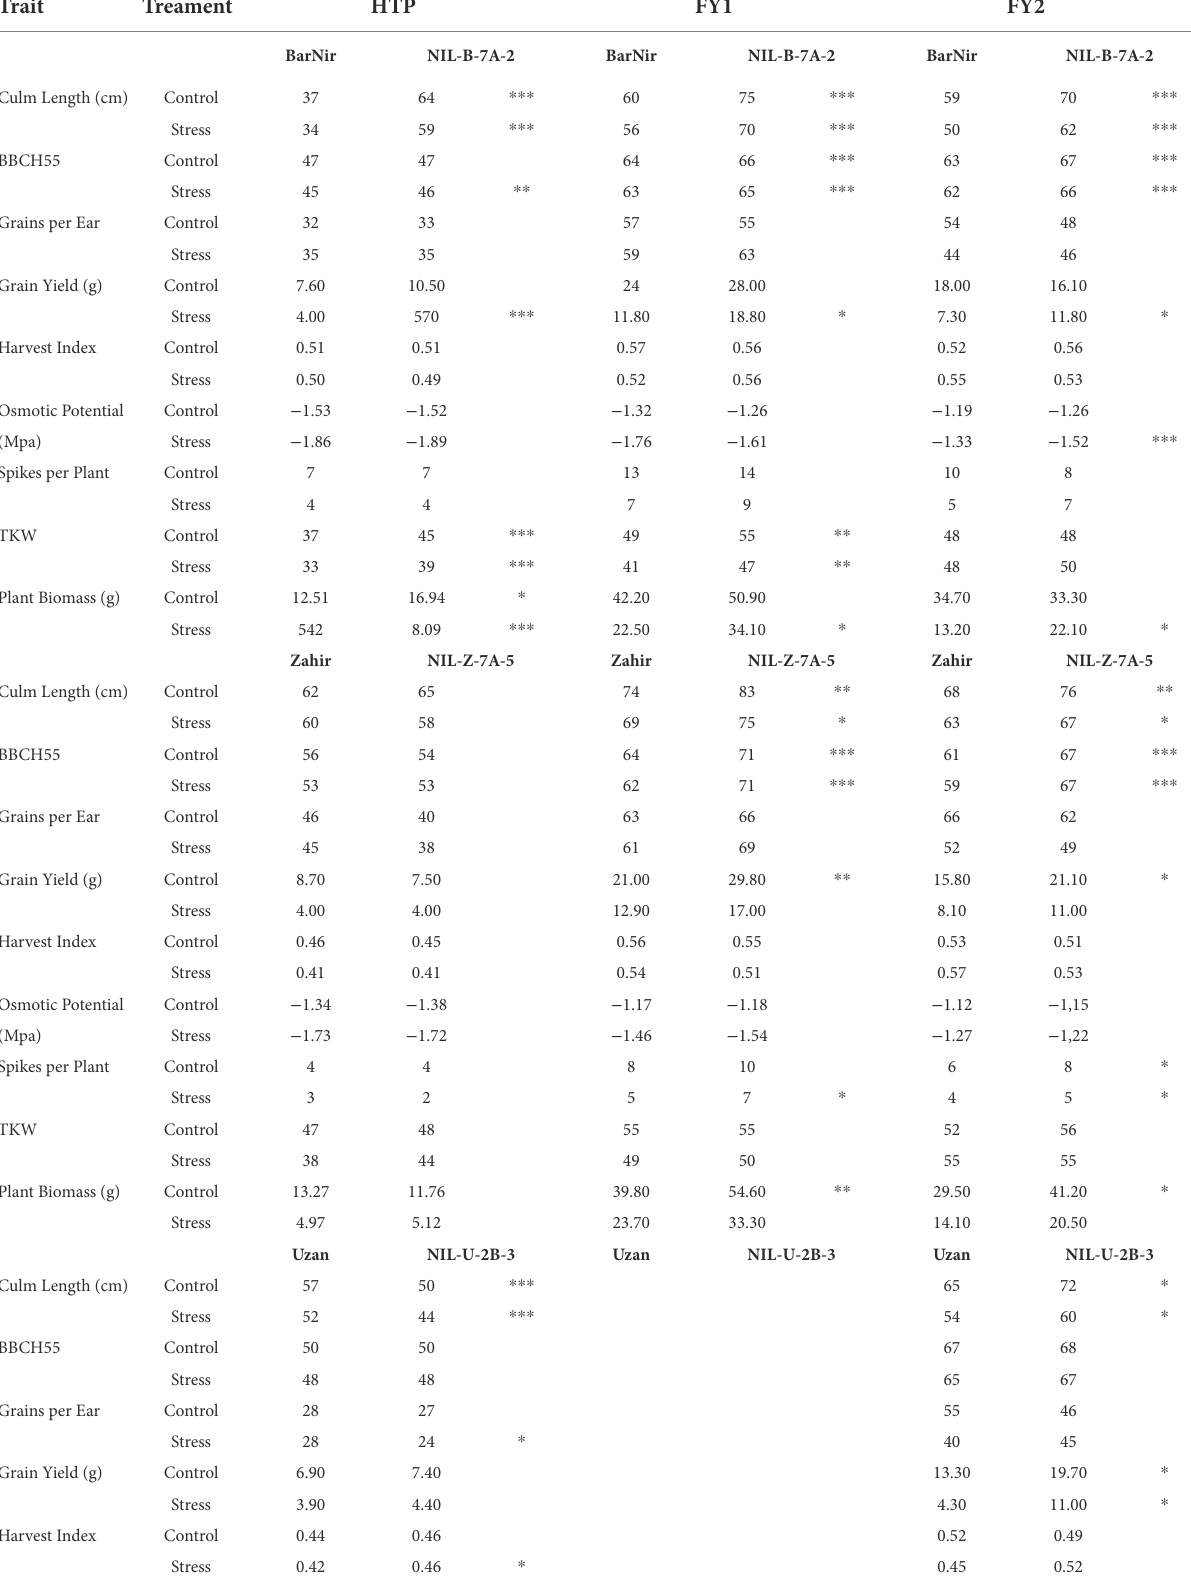
TABLE 5 Comparison of the absolute values (mean) of the NILs and the parents of common traits of the HTP experiment and field/screenhouse experiments. Trait Treament HTP FY1 FY2 BarNir NIL-B-7A-2 BarNir